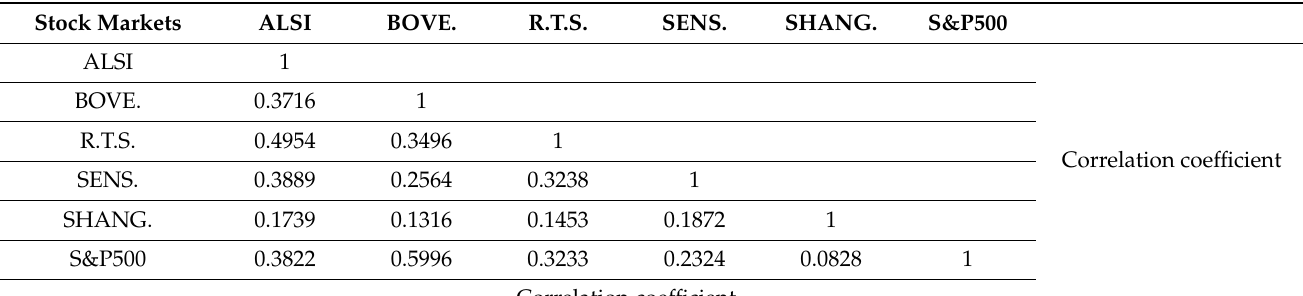
Table 2. Correlation matrix of the stock